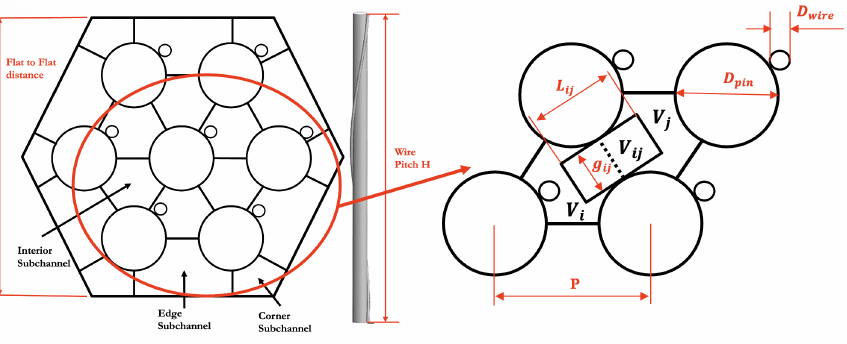
Figure 1. Hexagonal wire-wrapped assembly with triangular